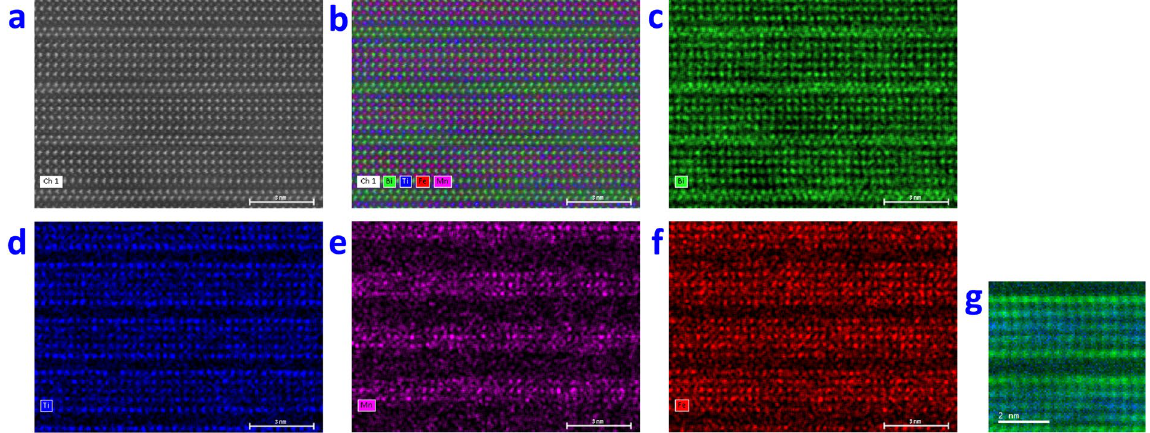
Figure 2. Representative atomic resolution chemical mapping images for B6TFMO-A in a region of the crystallite without out-of-phase boundaries (OPBs)/stacking faults. ( a ) Annular dark-field image and ( b to f ) corresponding EDX chemical composition maps: ( b ) overlay map showing annular dark-field image (white), Bi (green), Ti (blue), Mn (pink), Fe (red), ( c ) Bi map, ( d ) Ti map, ( e ) Mn map, ( f ) Fe map. ( g ) EELS chemical composition maps of a different region of B6TFMO-A (refer to Supplementary Figure S3(a) for corresponding HAADF-STEM image) with Ti in green and Mn in